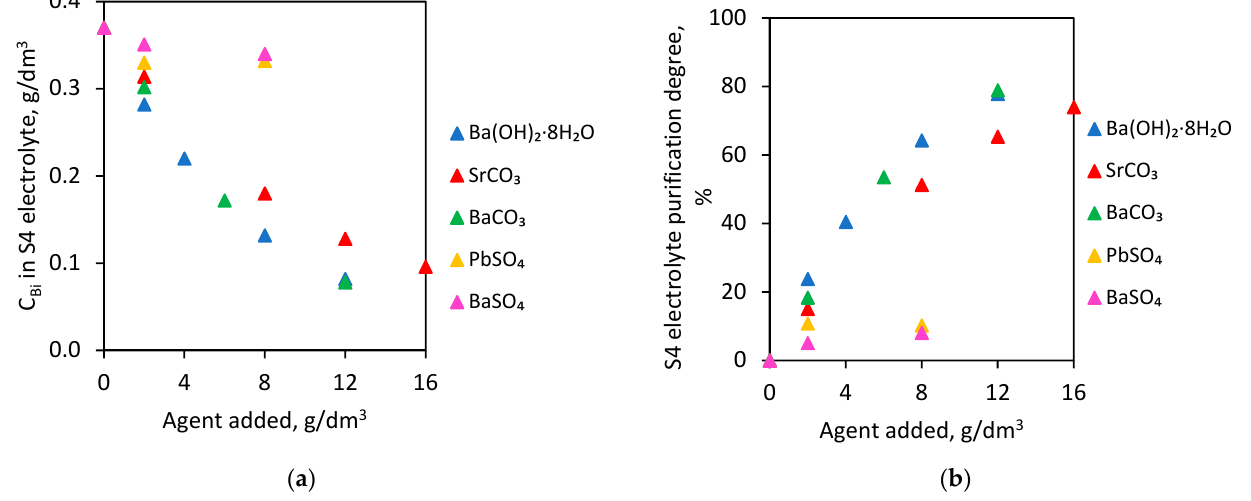
Figure 2. Barium hydroxide octahydrate, strontium carbonate, barium carbonate, barium sulfate and lead sulfate addition on ( a ) Bi concentration in S4 electrolyte and ( b ) S4 electrolyte purification degree. The addition of 12.0 g/dm 3 barium hydroxide octahydrate, 16.0 g/dm 3 strontium carbonate or 12.0 g/dm 3 barium carbonate to the S4 electrolyte caused a reduction of Bi concentration below 0.1 g/dm 3 . The initial Bi value—0.370 g/dm 3 in the S4